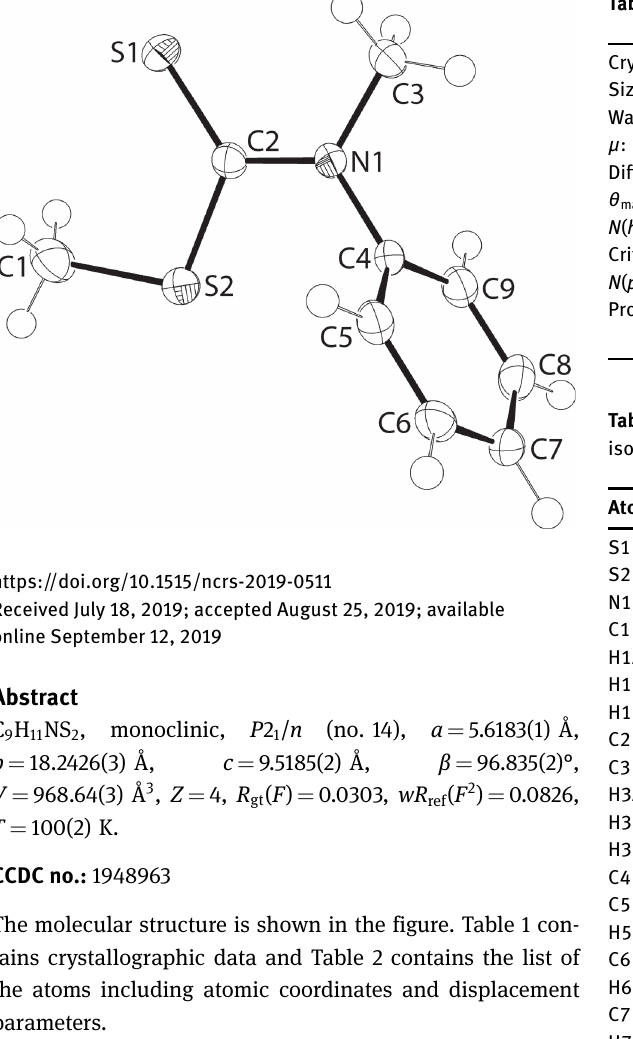
Table 1: Data collection and handling.